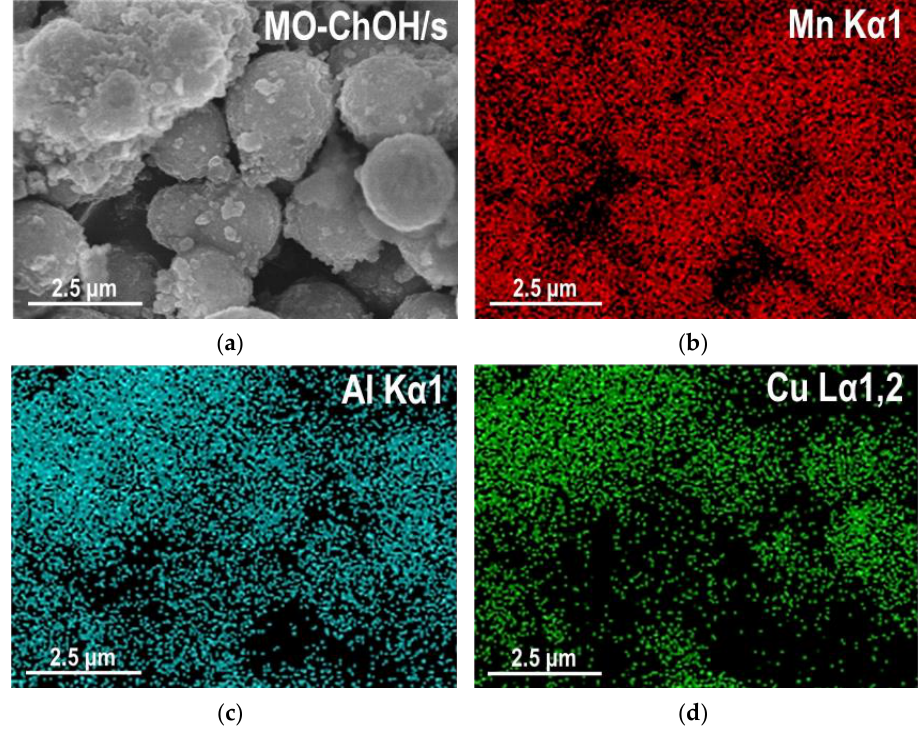
Figure 5. High-magnification SEM images of P-ChOH/s precursor and MO-ChOH/s mixed oxides showing close-ups of grains of different morphology: ( a ) P-ChOH/s, surface of irregular agglomerate; ( b ) P-ChOH/s, surface of spheroidal particle; ( c ) MO-ChOH/s, surface of irregular agglomerate; ( d ) MO-ChOH/s, surface of spheroidal particle. Magnification × 100,000.